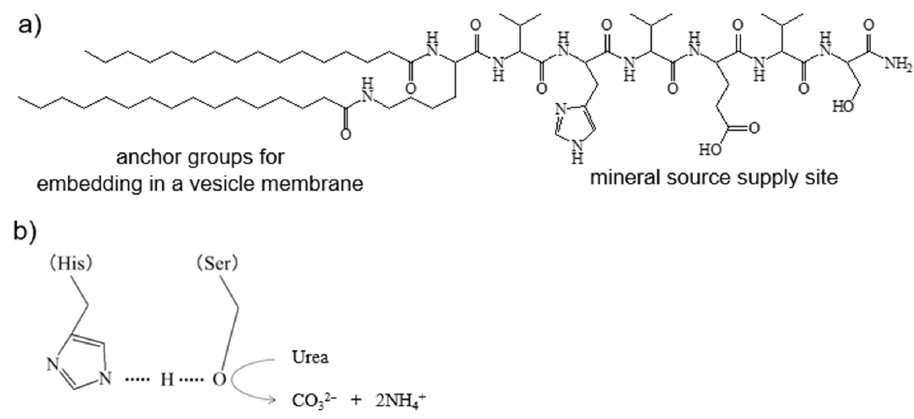
Figure 1. ( a ) Chemical structure of the peptide lipid. ( b ) Hydrolysis mechanism of urea by charge relay between His and Ser.